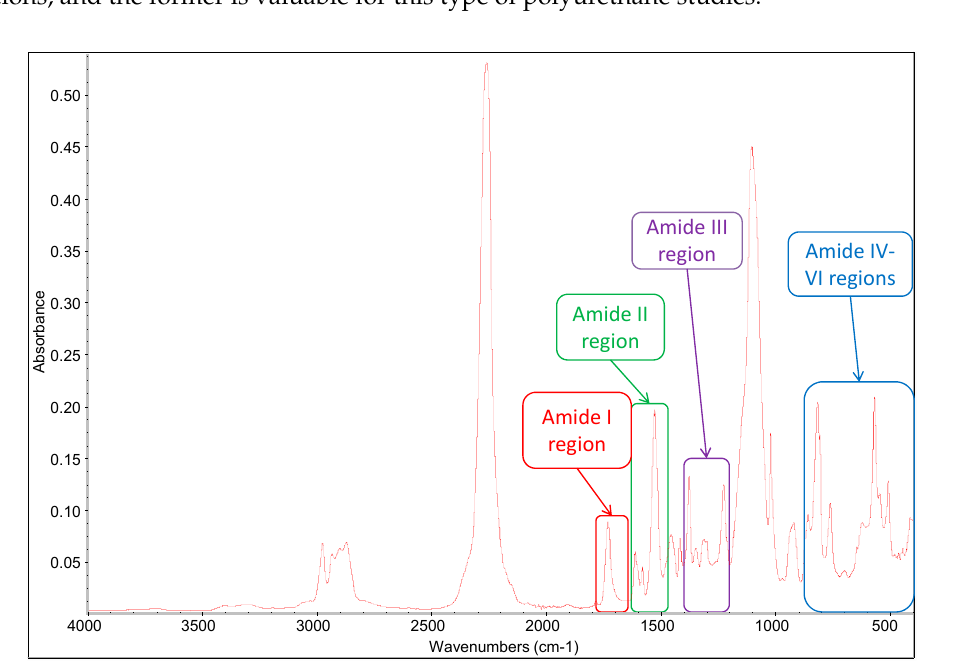
Figure 5. Attenuated total reflectance infrared spectroscopy (FTIR-ATR) spectrum of the blank sample UP 2 - O - 0 . Table 4. FTIR-ATR characteristic peaks assignment for UP 2 - O - 0 .